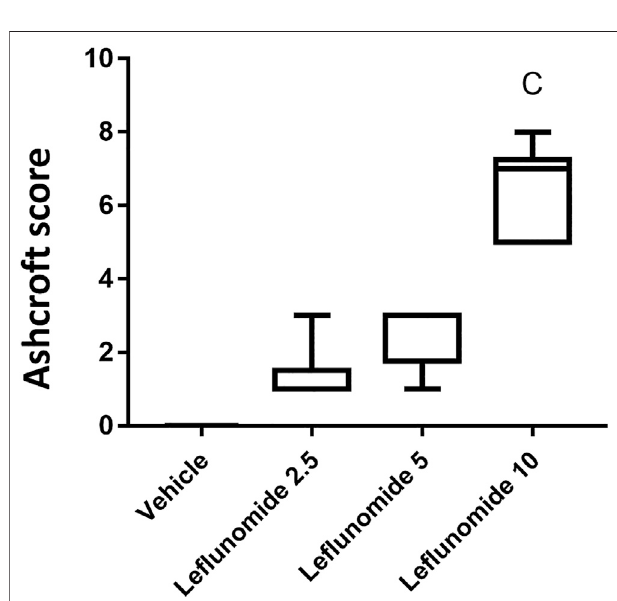
FIGURE5 | The Ashcroft scores forthe H&E stained lung sections . Data are box-plots representing the medians and quartiles. Statistical analysis was done with Kruskal-Wallis ANOVA and Dunn ’ s test. a: vs. vehicle group at p < 0.05.